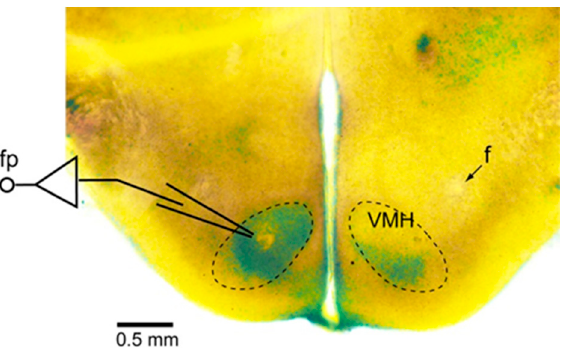
Figure 1. Slice preparation for field potential recordings in the ventromedial hypothalamus (VMH). The dashed lines denote the VMH. This preparation was briefly stained by 0.05% methylene blue. The field potential (fp) was recorded with a glass pipette set within the VMH. f: fornix.